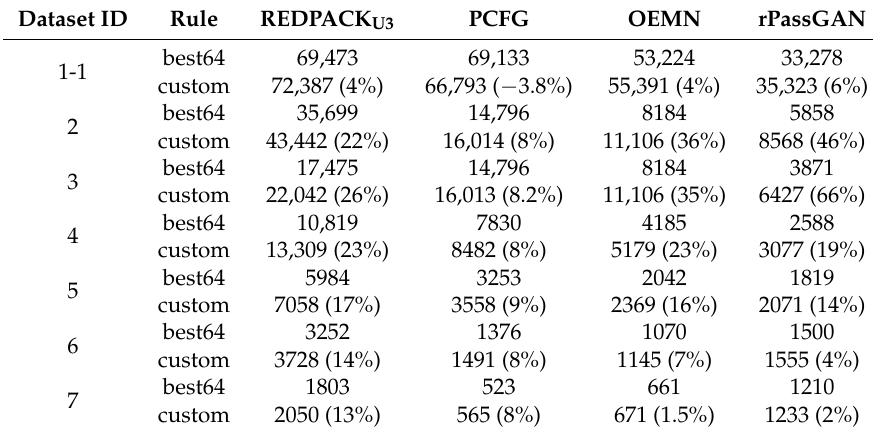
Table 5. Cracking performance of custom rule set for REDPACK; this custom set of rules was effective when applied to REDPACK. When this custom rule was applied to both the PCFG and OMEN, cracking performance of custom set of rules was less than that of best64 in some cases. Number in parentheses shows percentage increase or decrease in relation to